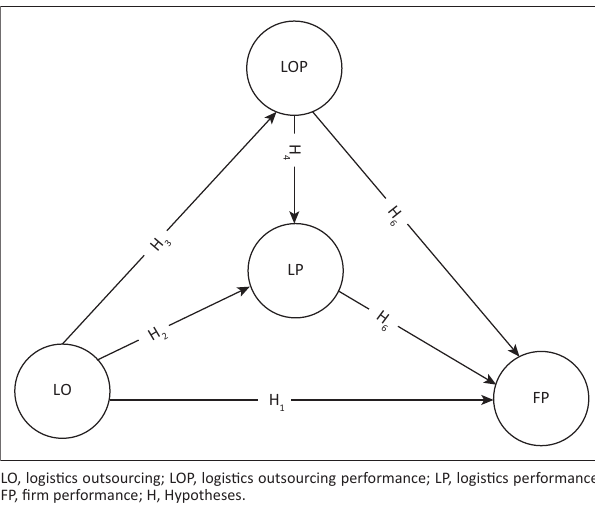
FIGURE 1: Conceptual framework for logistics